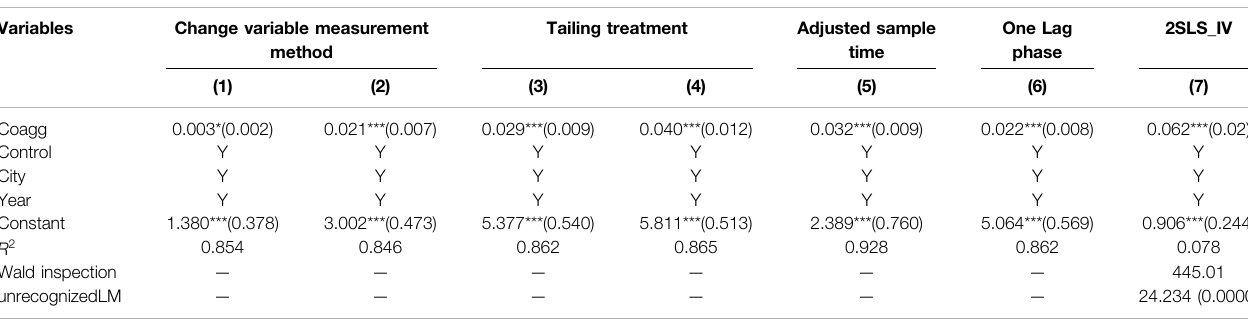
TABLE 6 | Results of the robustness